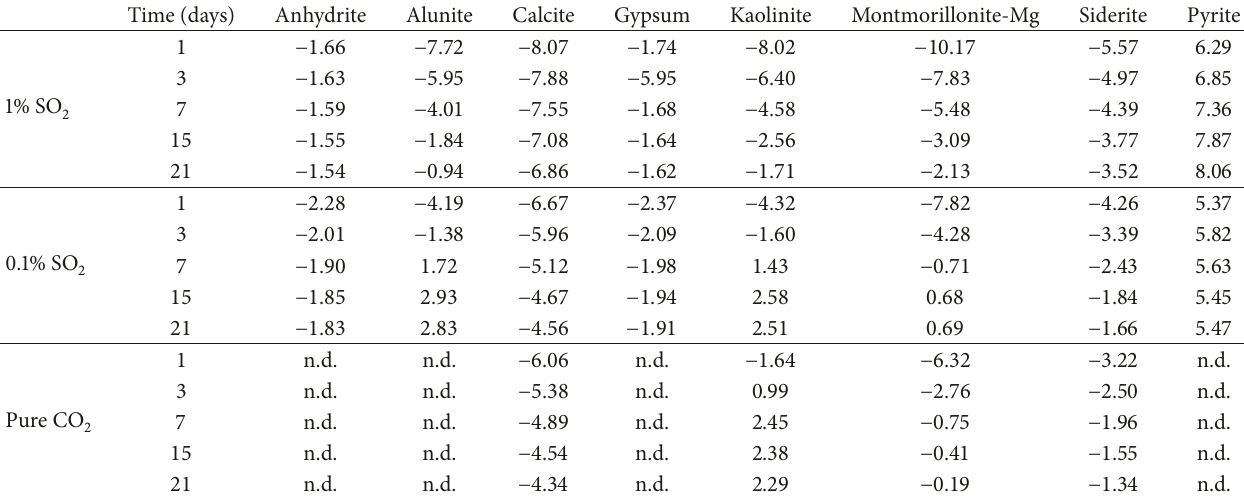
Table 4: Calculated mineral saturation indices with reaction